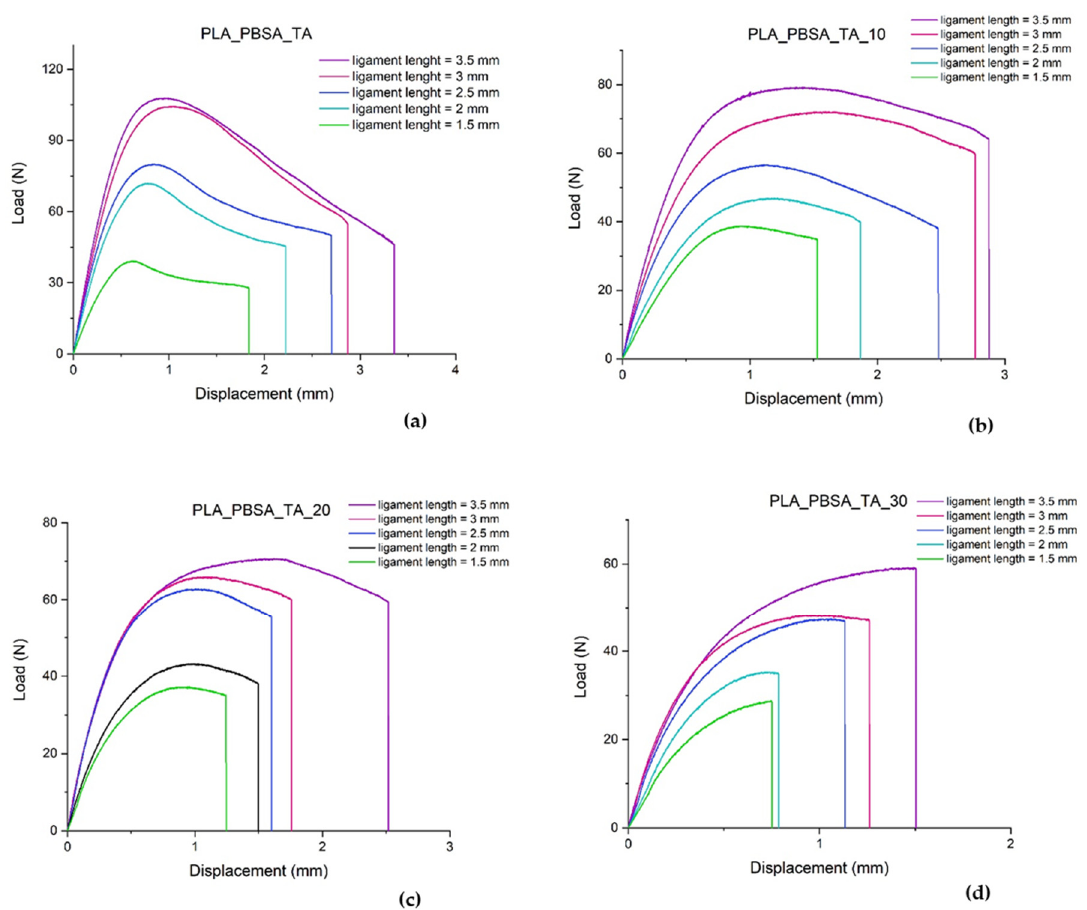
Figure 8. Load displacement curves of plasticized PLA/PBSA blend with and without bran at dif- ferent ligament lengths.